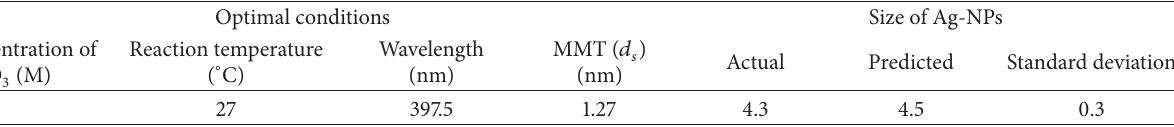
Figure 3: The scatter plots of ANN model predicted versus actual values for training, validation, testing, and all data sets. Table 4: Optimum conditions derived by ANN for the prediction of size of